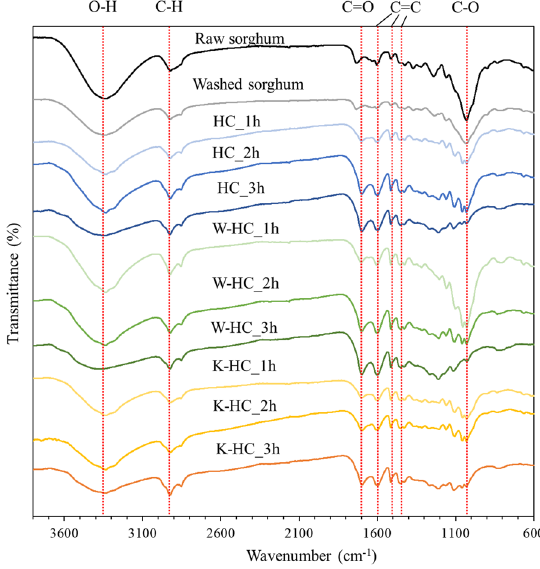
Fig. 3 FTIR spectrum of raw material and hydrochar Fig. 4 Mass yield of hydrochar at 250